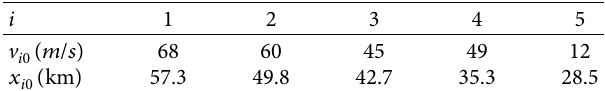
Table 3: The initial states of the high-speed